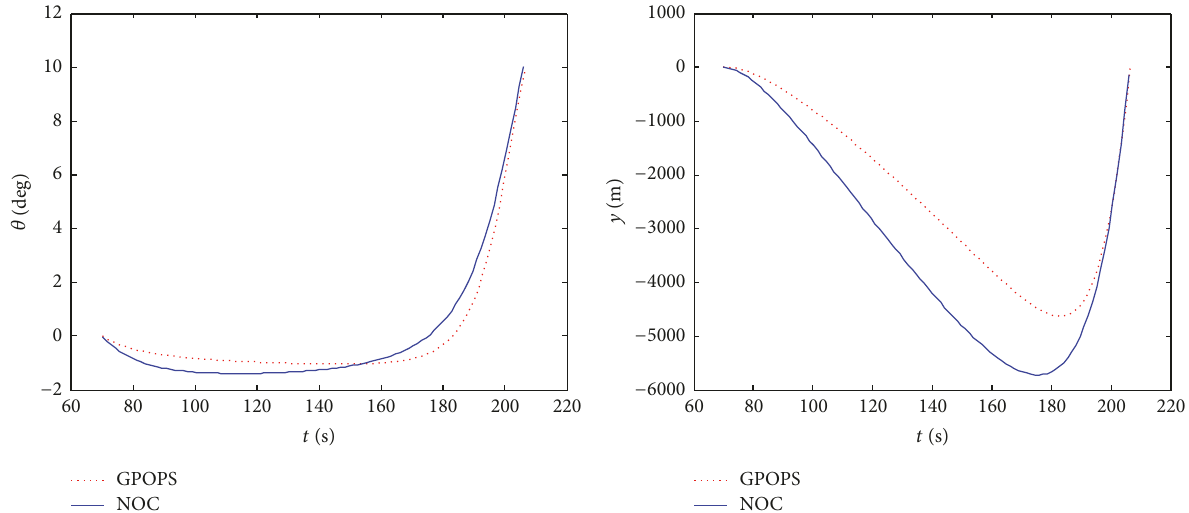
Figure 8: Curves of modifications with flight path angle increasing 10deg.